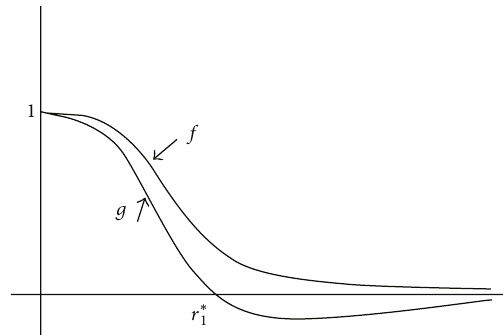
Figure1:Typicalformsofthenormalizedlongitudinalandtransver- sal correlation